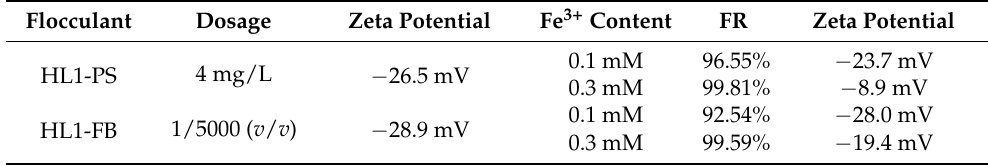
Table 3. Flocculation rate of HL1-PS and HL1-FB.